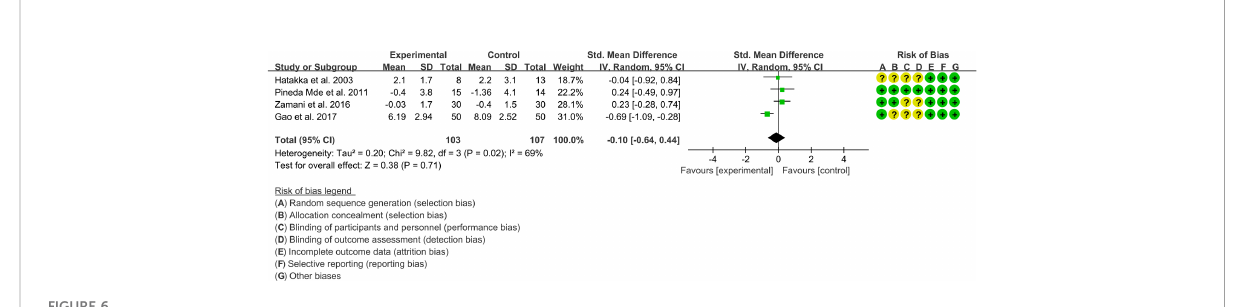
FIGURE 6 Swollen joint count (CI, con fi dence interval; SD, standard deviation).